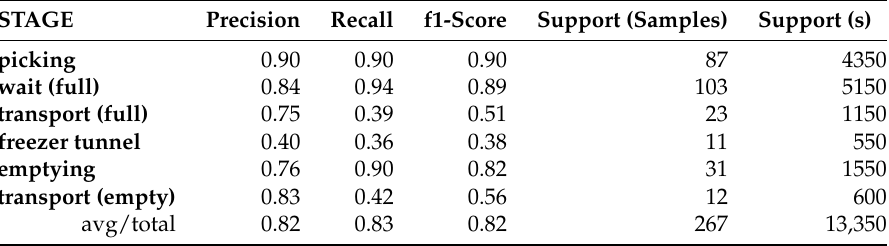
Table 1. Performance of the K-Nearest Neighbors algorithm (KNN) using validation